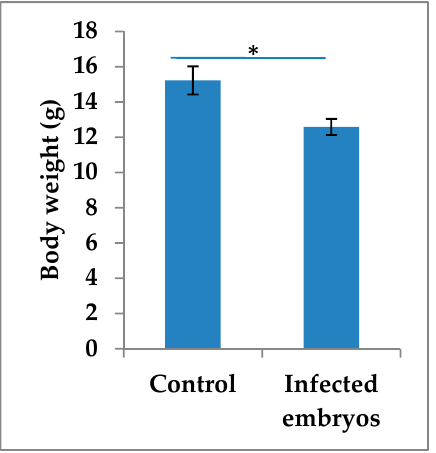
Figure 6. Comparison of the body weights on day 5 of the experiment between control and infected chicken embryos with the USU-BE-Seraing/2017 strain using the allantoic route. Bars indicate means ± standard deviation; n = 5 per condition; “*” indicates a p -value < 0.05.